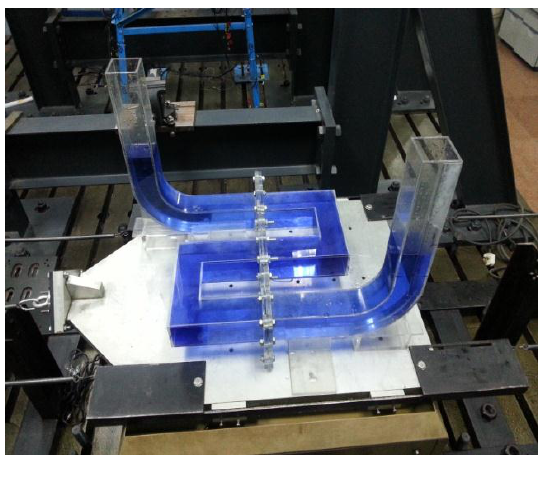
Figure 3. S-shaped TLCD.